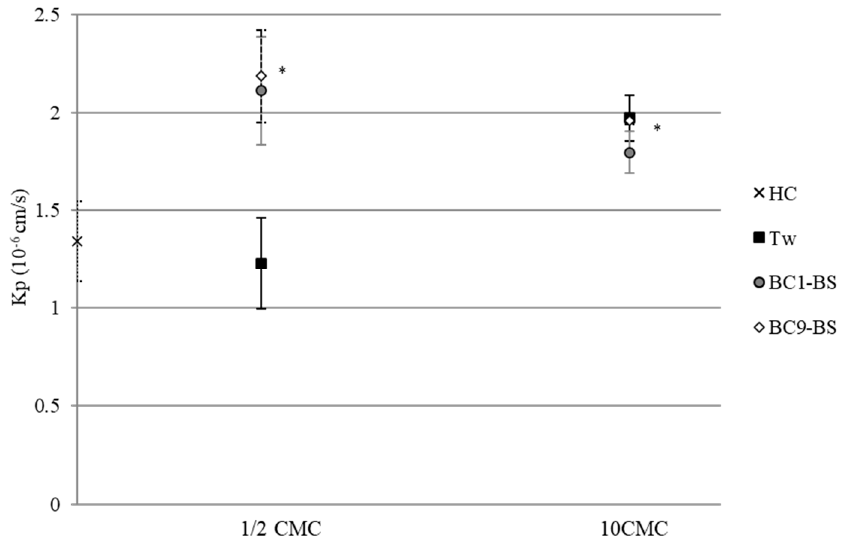
Figure 5. HC permeability coefficients (Kp) in the absence and presence of various surfactant concentrations. Data are expressed as means ± SD, n = 5. Significance indicated by * = p < 0.05 compared to Kp of HC.